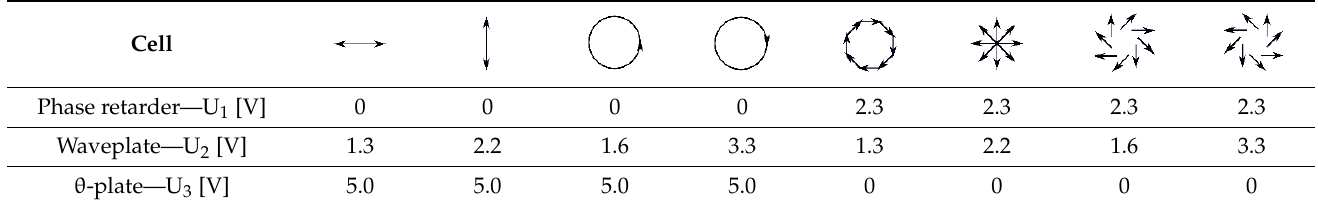
Table 1. The driving voltages for the NLC-PC device that results in the desired output SOP for the transmitted beam are presented for the Gaussian linear polarized beam of wavelength λ = 1064 nm. Cell